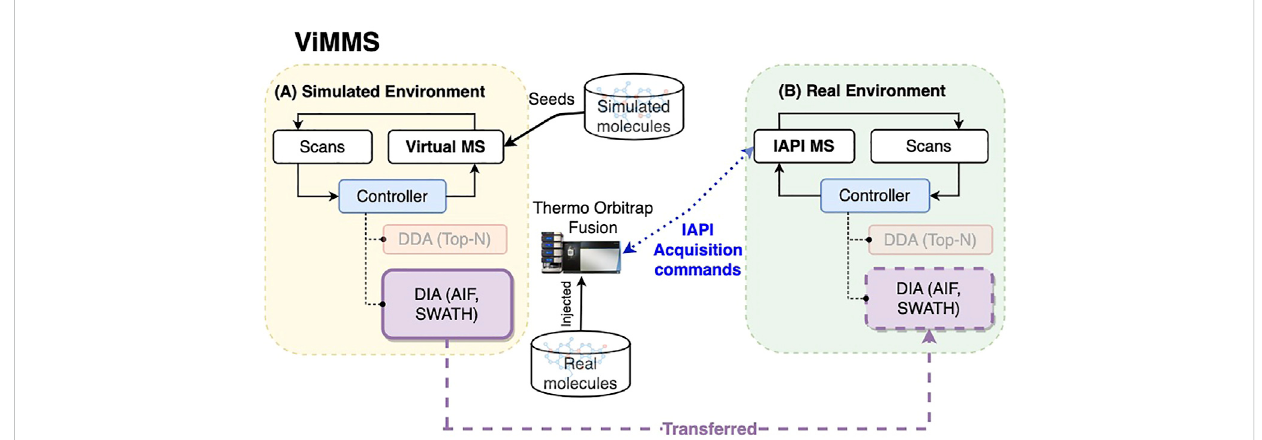
FIGURE 1 The overall schematic of the ViMMS framework. (A) The Simulated Environment in ViMMS allows for new acquisition methods to be developed against a Virtual MS that takes simulated molecules as input. The new DIA methods, e.g., SWATH and AIF (solid purple box), as well as existing DDA methods (faded orange box), are implemented as controllers and initially tested here in the Simulated Environment. A controller is a speci fi c Python implementation of an acquisition method in ViMMS. (B) Acquisition methods can be run for method validation on the Real Environment in ViMMS, connected to a Thermo Orbitrap Fusion instrument via IAPI, to acquire real experimental scans.Controllers developed in theSimulatedEnvironment can be transferred to the Real Environment easily (shown by the dashed purple line). As different environments abstract the low-level scan generation process, the underlying Python controller codes for the new DIA methods remain unchanged when transferred from the Simulated to the Real Environment (dashed purple